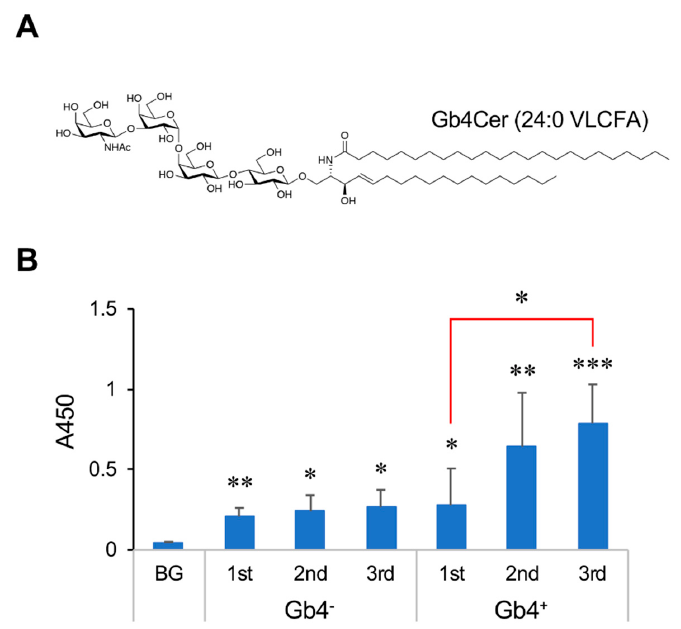
Figure 1. Reactivity of the serum of mice immunized with globotetraosylceramide containing very-long-chain fatty acids (Gb4Cer-VLCFAs) against Gb4Cer. ( A ) Chemical structure of Gb4Cer containing C24:0 VLCFA. ( B ) Mice were immunized with Gb4Cer-VLCFAs using a liposome method as described in Materials and Methods , and serum samples prepared 3 days after the first subcutaneous immunization(1st)andthesecond(2nd)andthird(3rd)intraperitonealimmunizationswereanalyzedby enzyme-linked immunosorbent assay (ELISA). BG, serum from un-treated mice; Gb4 + , serum from mice immunized with Gb4Cer-containing liposomes; Gb4 − , serum from mice immunized with Gb4Cer-free liposomes. Error bars: mean ± S.D. ( n = 3–5). * p < 0.05, ** p < 0.01, *** p < 0.001 BG vs. each serum or 1st vs. 3rd (red